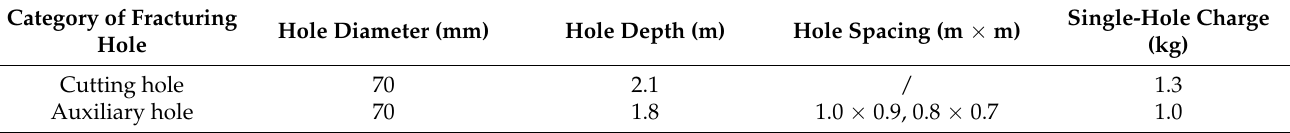
Table 1. Rock mass cracking parameters of the tests.